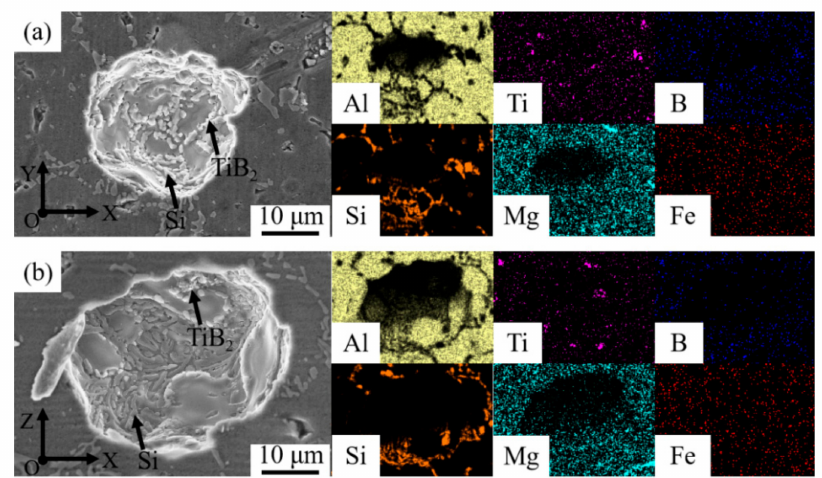
Figure 4. Stomata morphology of the WAAM-CMT-printed TiB 2 /AlSi7Mg0.6 sample in face XOY and XOZ: ( a ) face XOY; ( b ) face